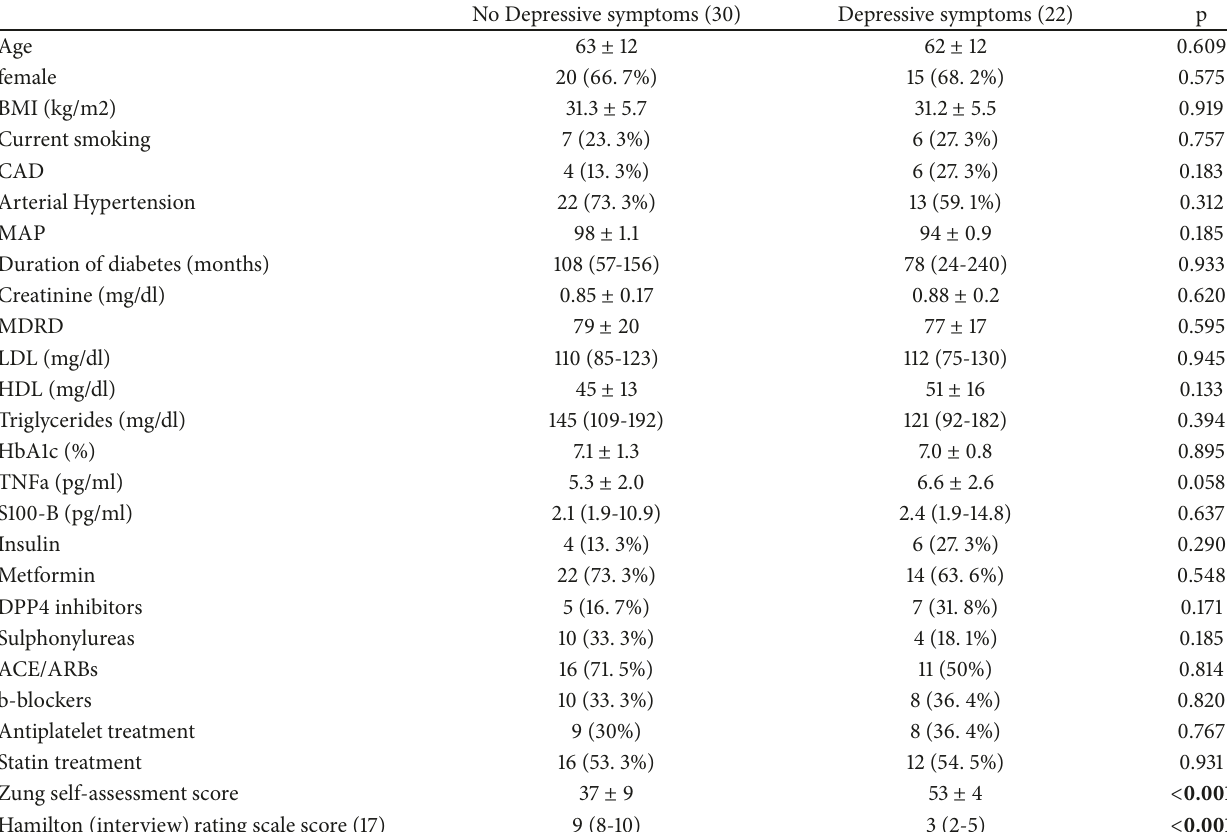
Table 2: Comparison of characteristicsof type 2 Diabetes Mellitus patients without depressive symptoms vs type 2 Diabetes Mellitus patients with depressive